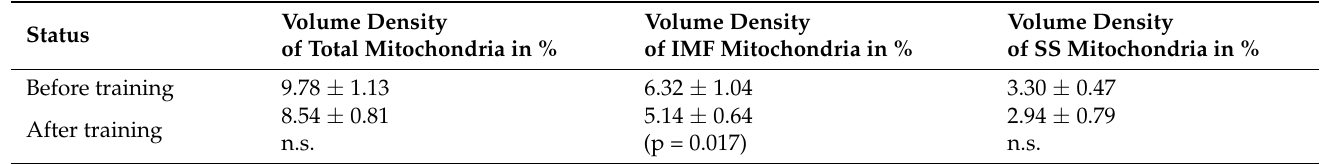
Table 1. Mitochondrial content (% volume) in gastrocnemius muscle of the studied subjects before and after endurance training.